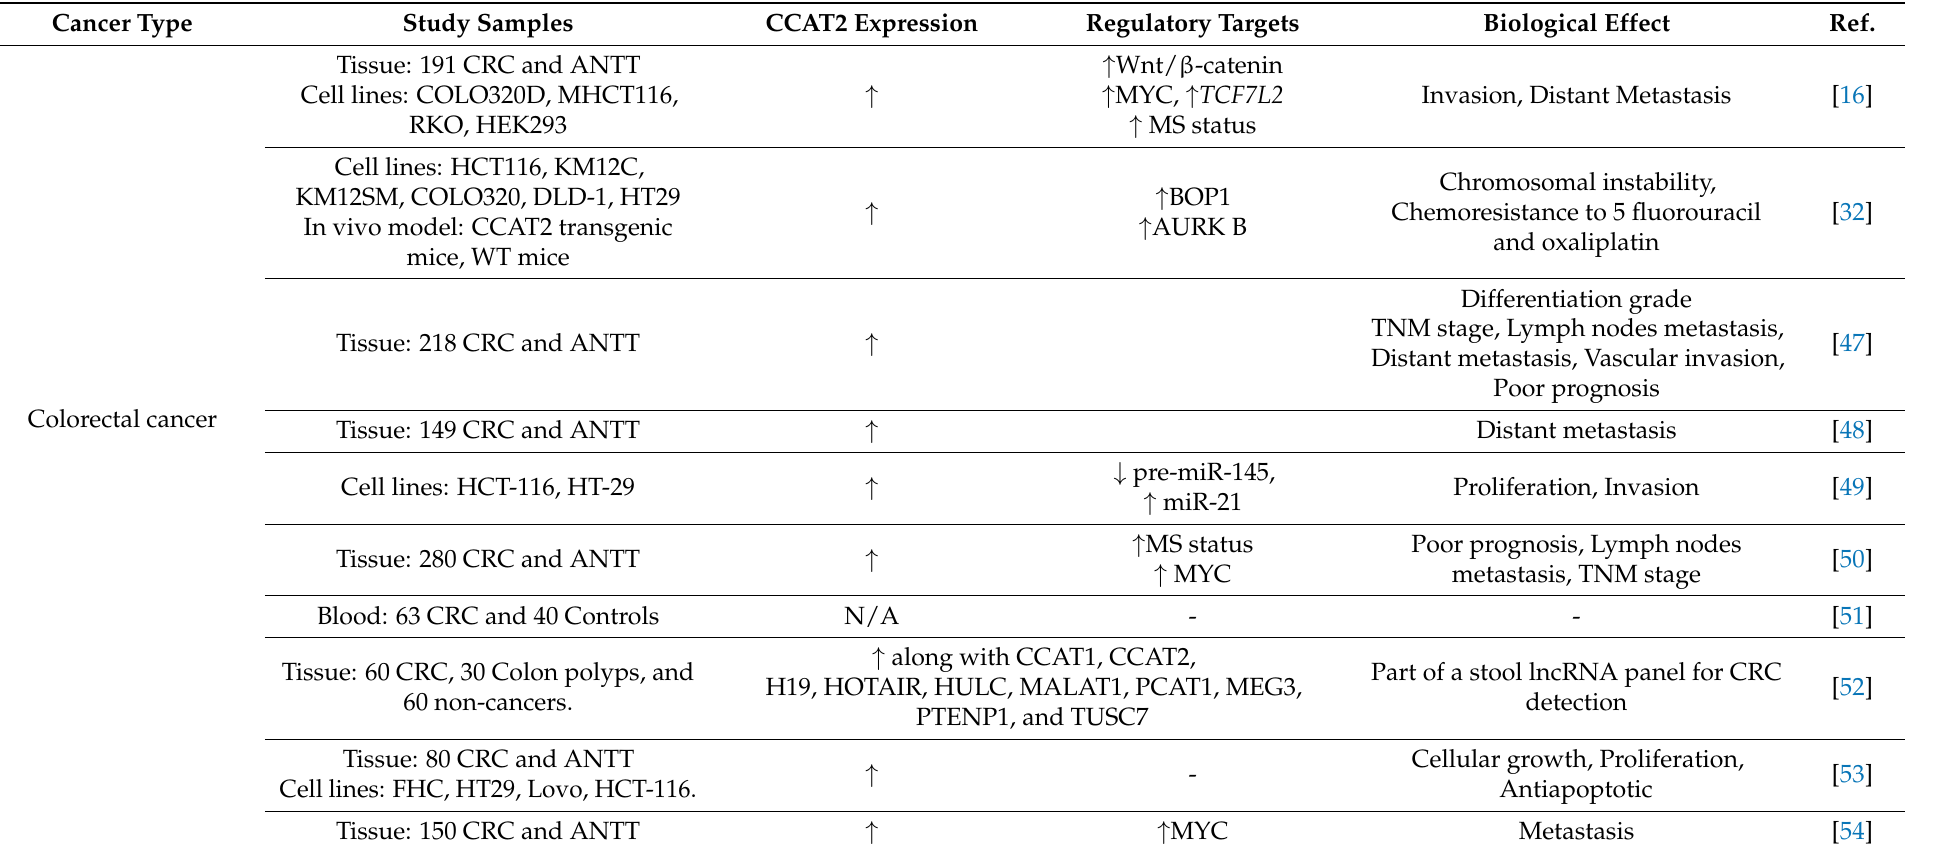
Table 1. Currently known regulatory targets and biological effects of different expression patterns of CCAT2 in various cancer